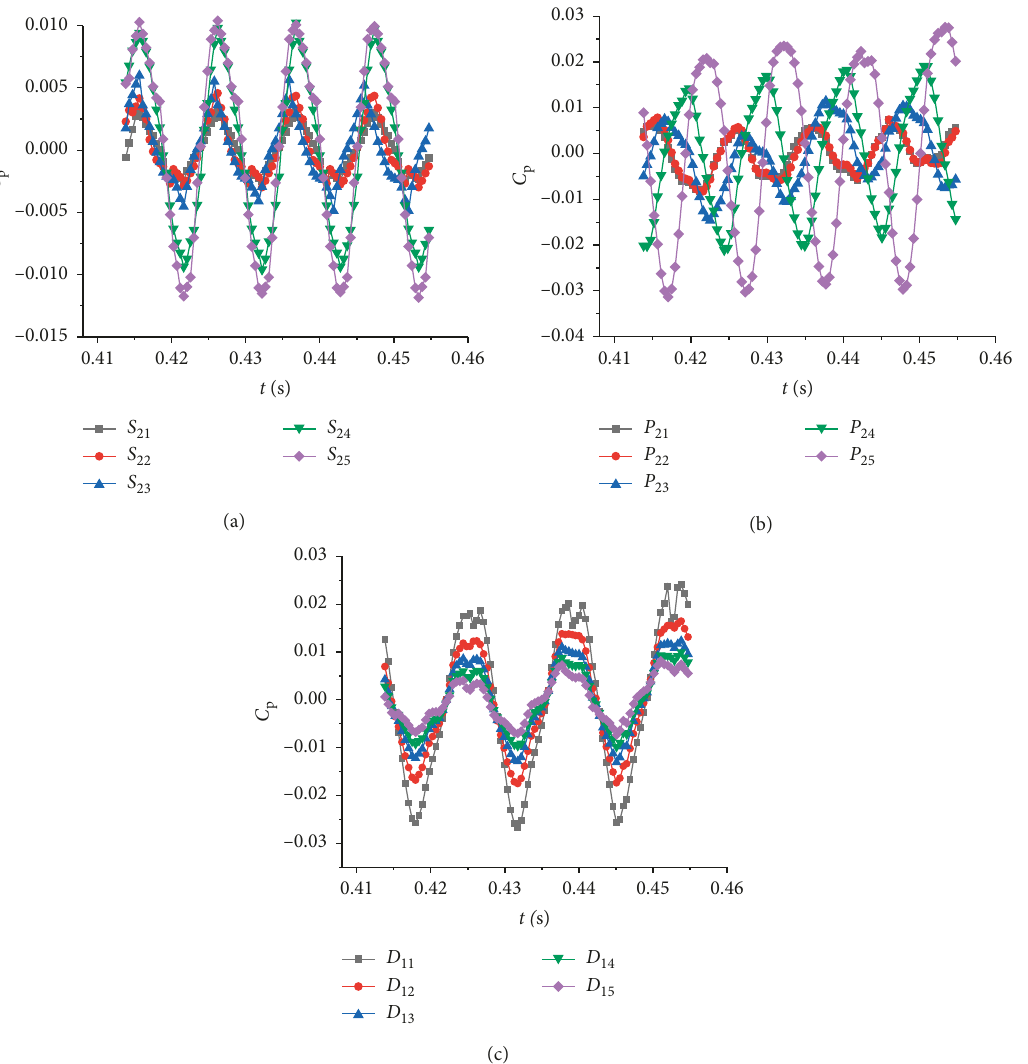
Figure 10: Pressure pulsation time-domain diagram of the second stage: (a) impeller blade suction side, (b) impeller blade pressure side, and (c)